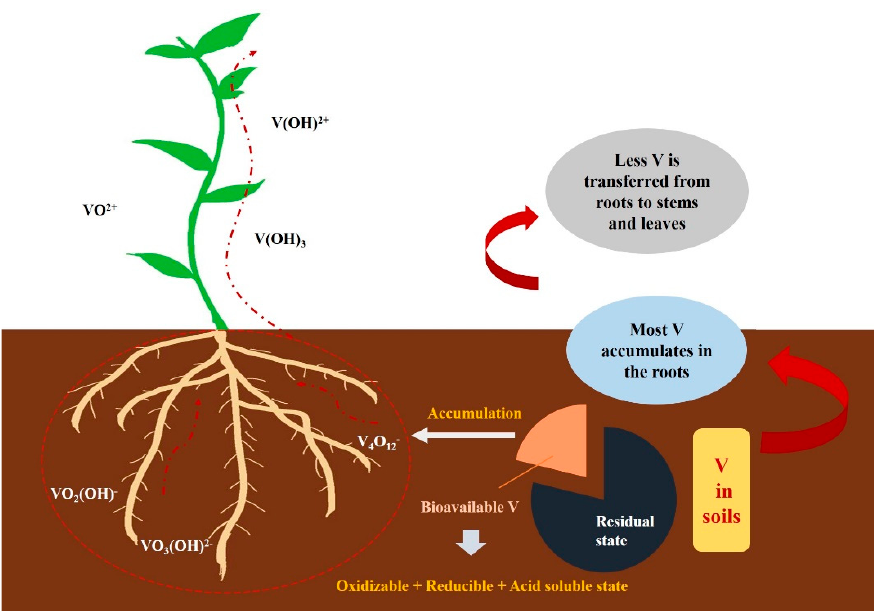
Figure 1. The absorption and transformation of V in